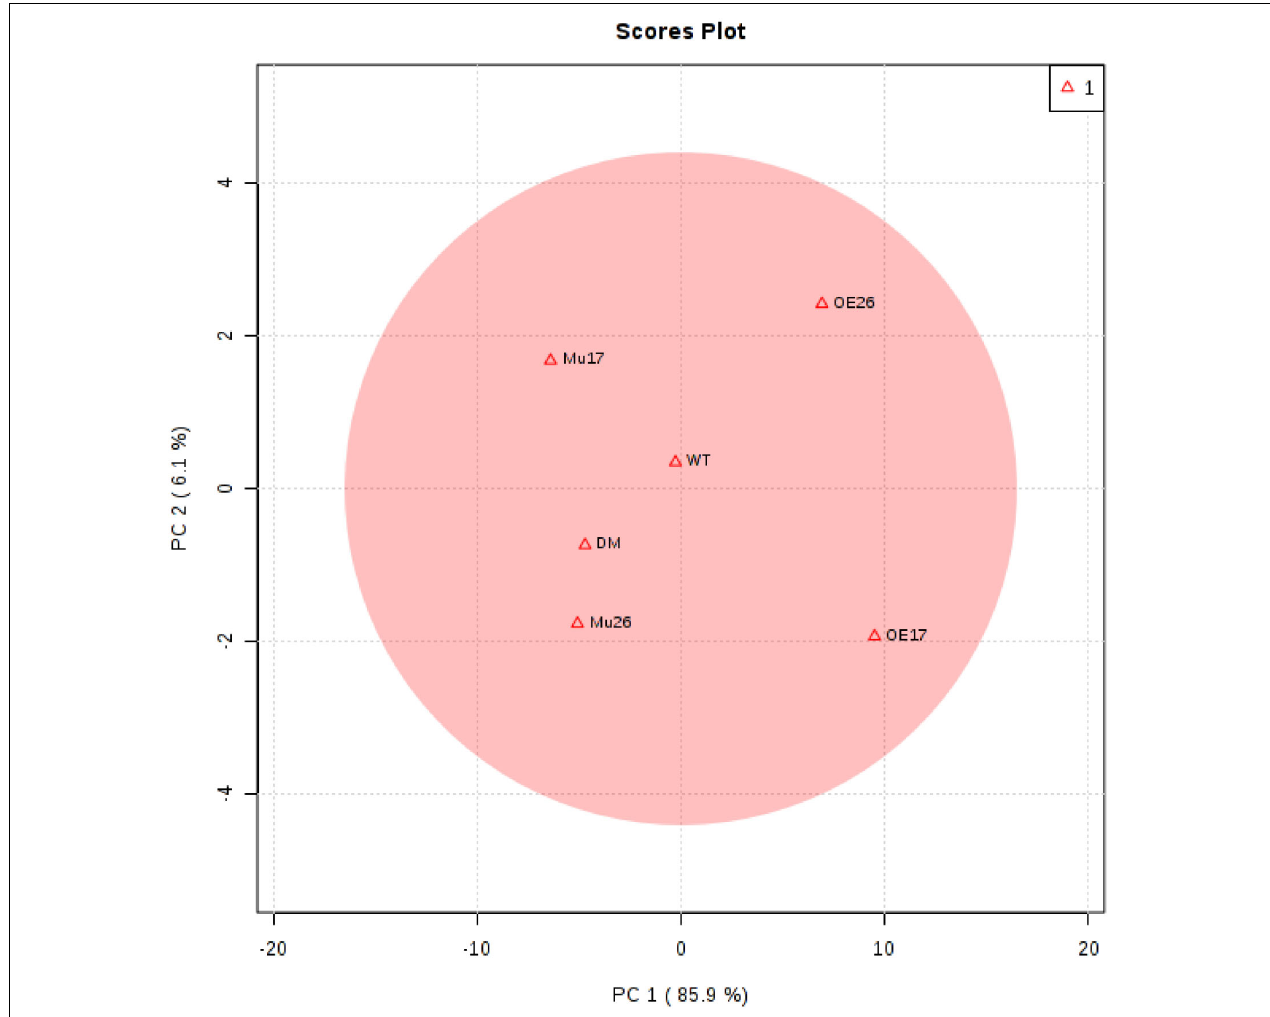
FIGURE 11 | Principal component analysis (PCA) results for all morphological and physiological parameters of the examined genotypes to show grouping of them 150 mM NaCl stress. Wild-type (WT), overexpress (OE), single mutant (Mu), and double mutant (DM) genotypes of Arabidopsis thaliana purple acid phosphatase 17 ( AtPAP17 ) and 26 ( AtPAP26 )